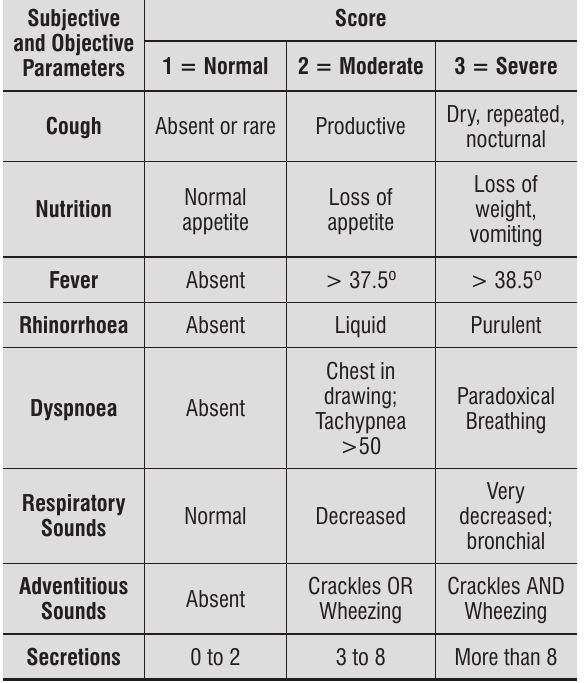
Table 1 - Final Portuguese version of Paediatric Respira- tory Severity Score